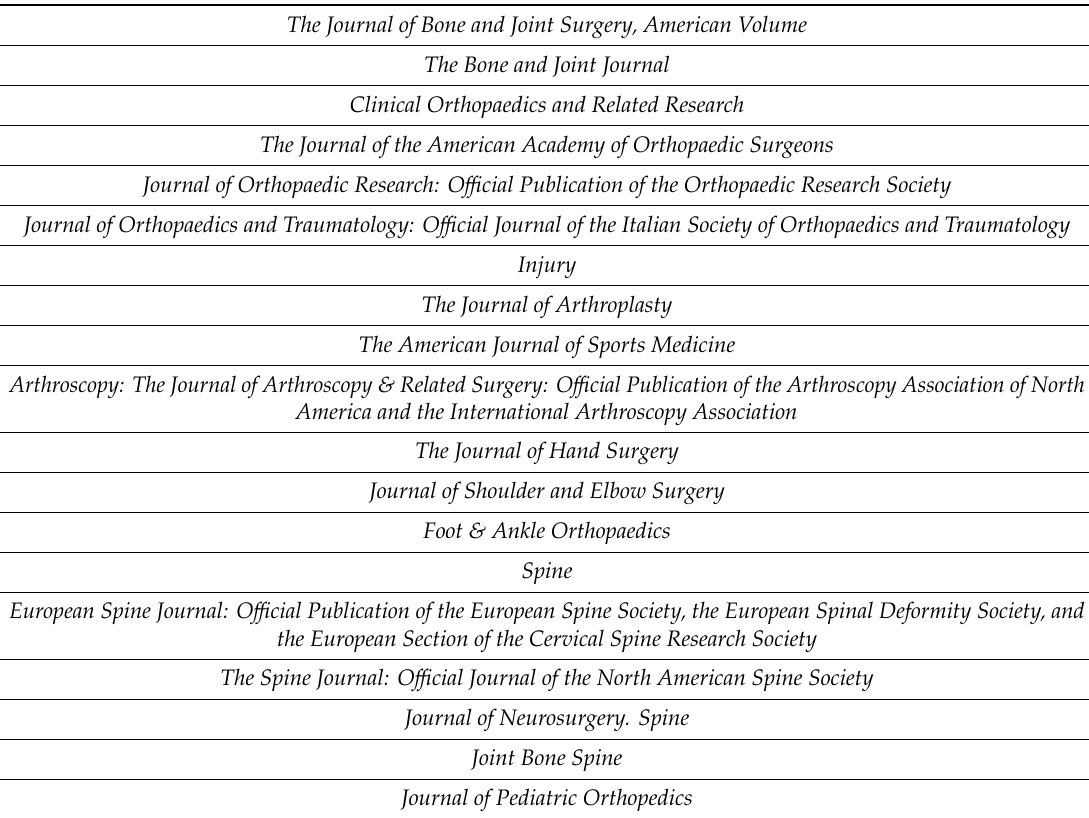
Table A1. High Impact Orthopedic Journals Used in Secondary